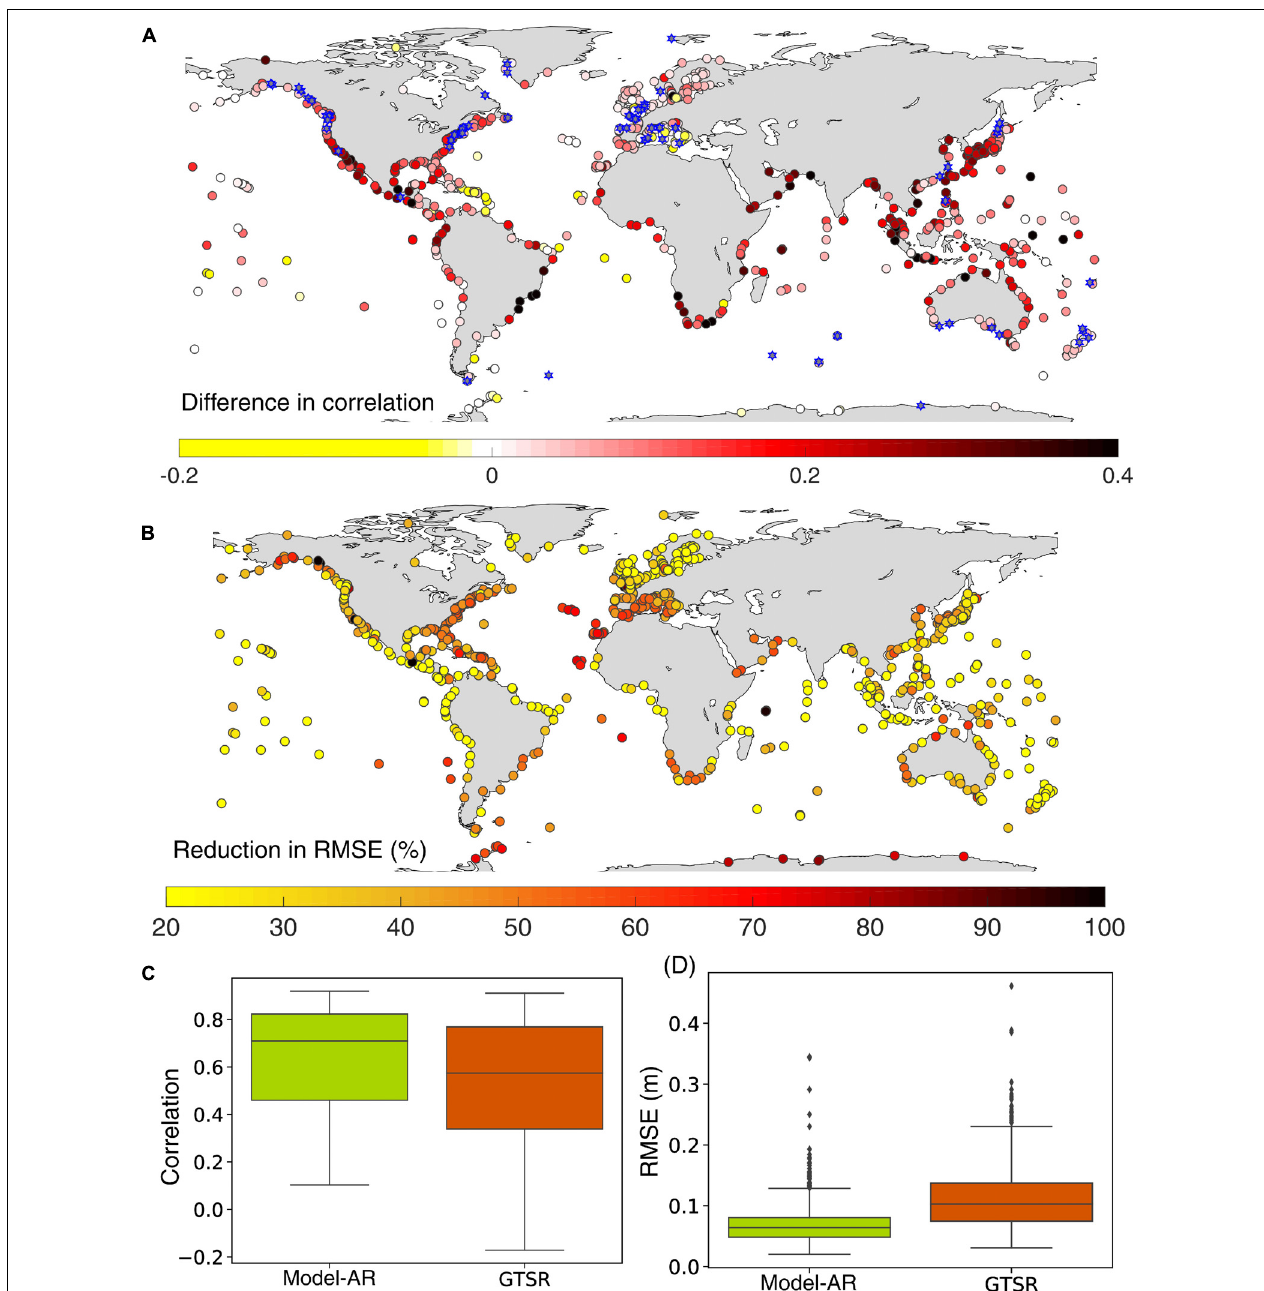
FIGURE 11 | Comparison of Model-AR with GTSR. (A) Difference in Pearson’s correlation coefficients of Model-AR and GTSR with observations. Red colors indicate that Model-AR has higher correlation than GTSR, whereas blue stars denote tide gages where the difference in correlation is insignificant. (B) Reduction of RMSE in Model-AR compared to GTSR expressed in percent. Boxplot comparison of correlation (C) and RMSE (D) for Model-AR and GTSR.